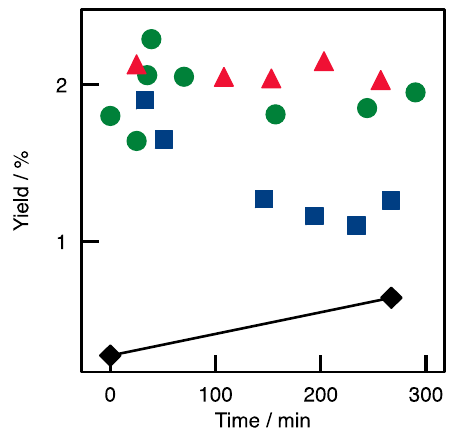
Figure 7. APTES and glutaraldehyde pre-activation effects on biocatalysts efficiency: ( ■ ) Si(HIPE); ( ● )